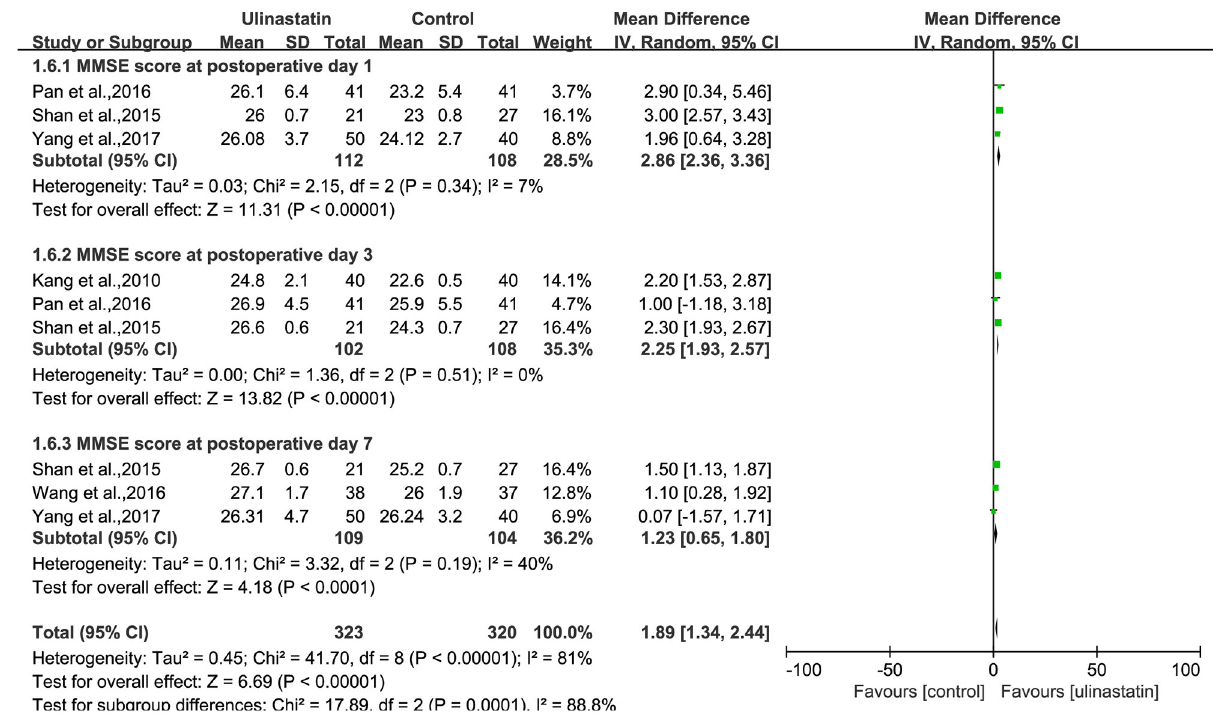
FIGURE 5 | Forest plot: Comparing the Mini-Mental State Examination (MMSE) scores of patients receiving ulinastatin vs. control divided by postoperative days 1, 3, 7.